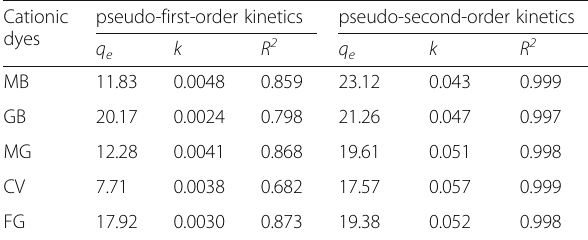
Table 1 Kinetics parameters for the adsorption of cationic dyes on Fe 3 O 4 /PCC MNPs Cationic dyes